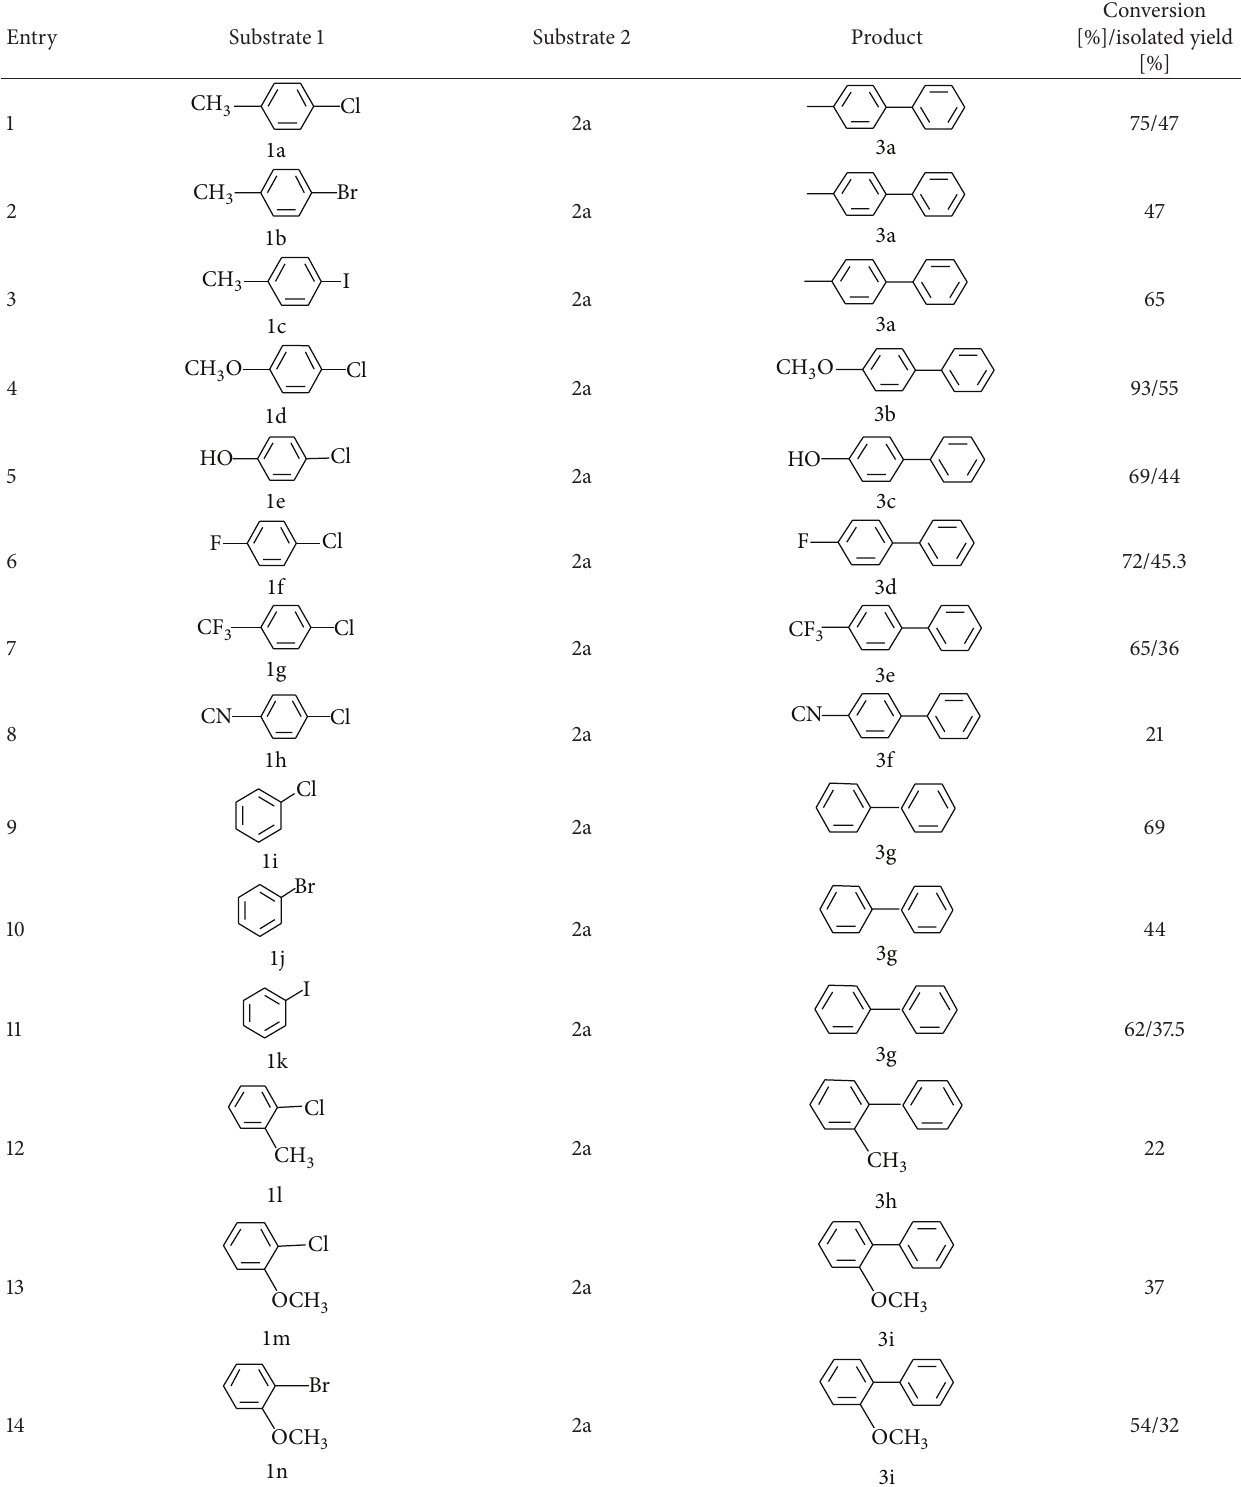
Table 2: Direct cross-coupling of benzene with different aryl halides a (see Scheme